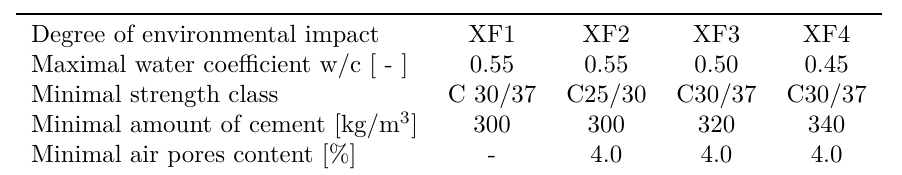
Table 1. Requirements for properties and composition of concrete according to EN 206